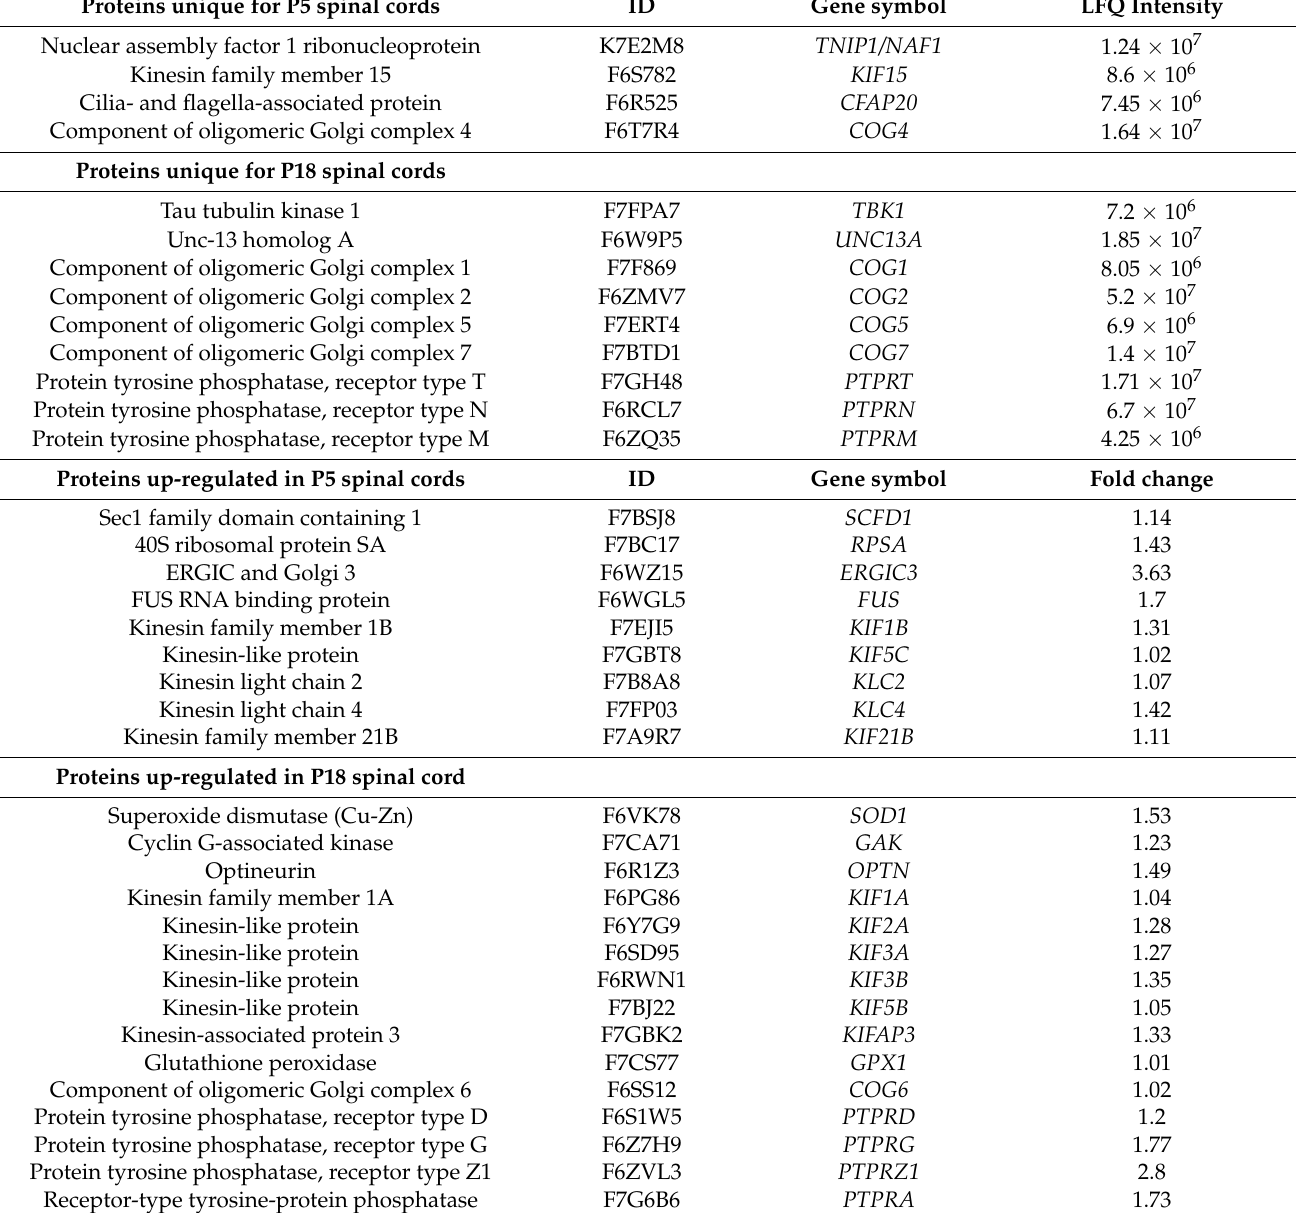
Table 2. Proteins related to ALS and detected by mass spectrometry as differentially distributed in P5 and P18 opossum spinal